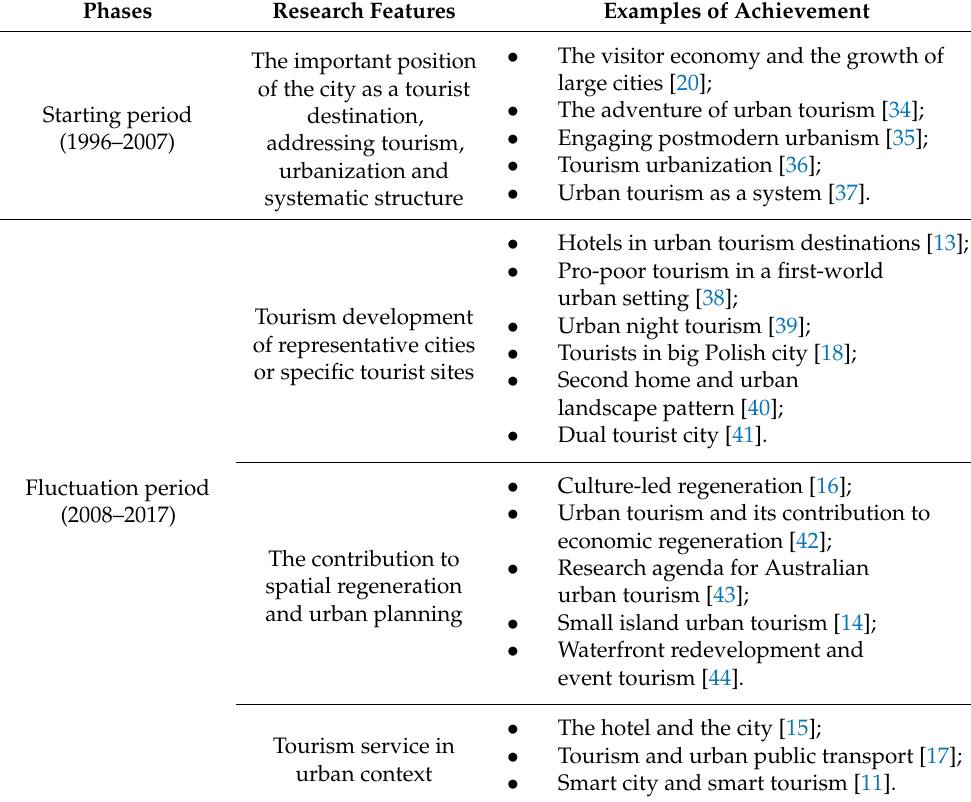
Table 1. Main theoretical progress and typical